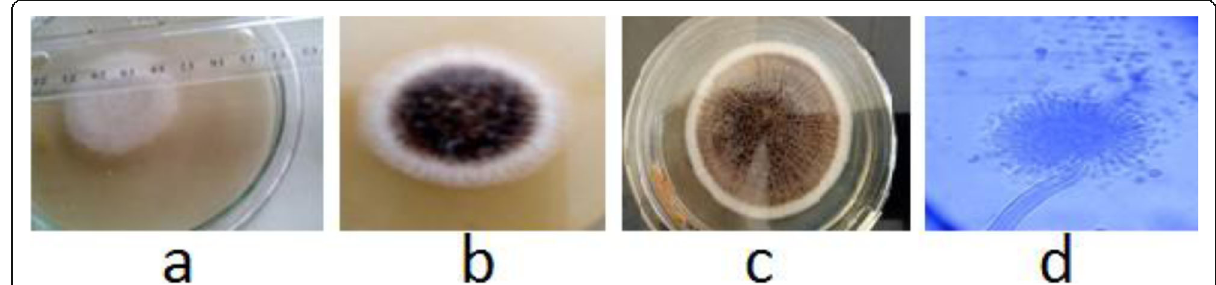
Fig. 4 The morphological characteristics of the isolated Aspergillus niger ( a whitish cottony growth at 24 h; b black growth at 72 h; c loose column at 96 h; d microscopic view of the colonial head)